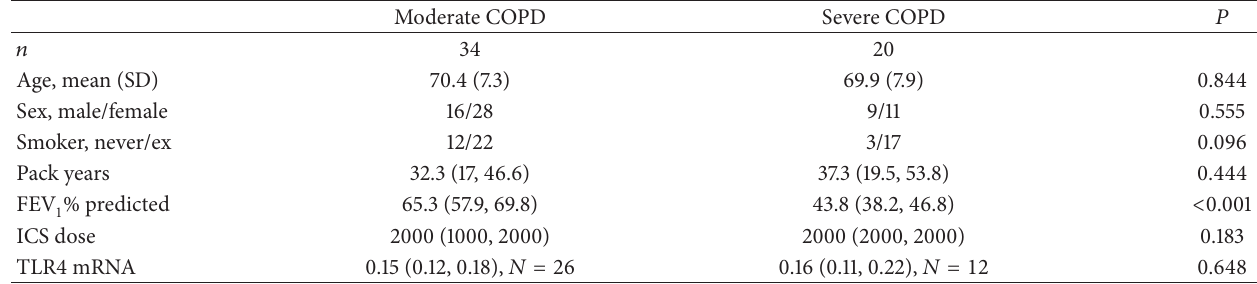
Table 3: Clinical and inflammatory outcomes according to the severity of airflow obstruction in patients with COPD. Data are median (q1, q3) unless indicated.